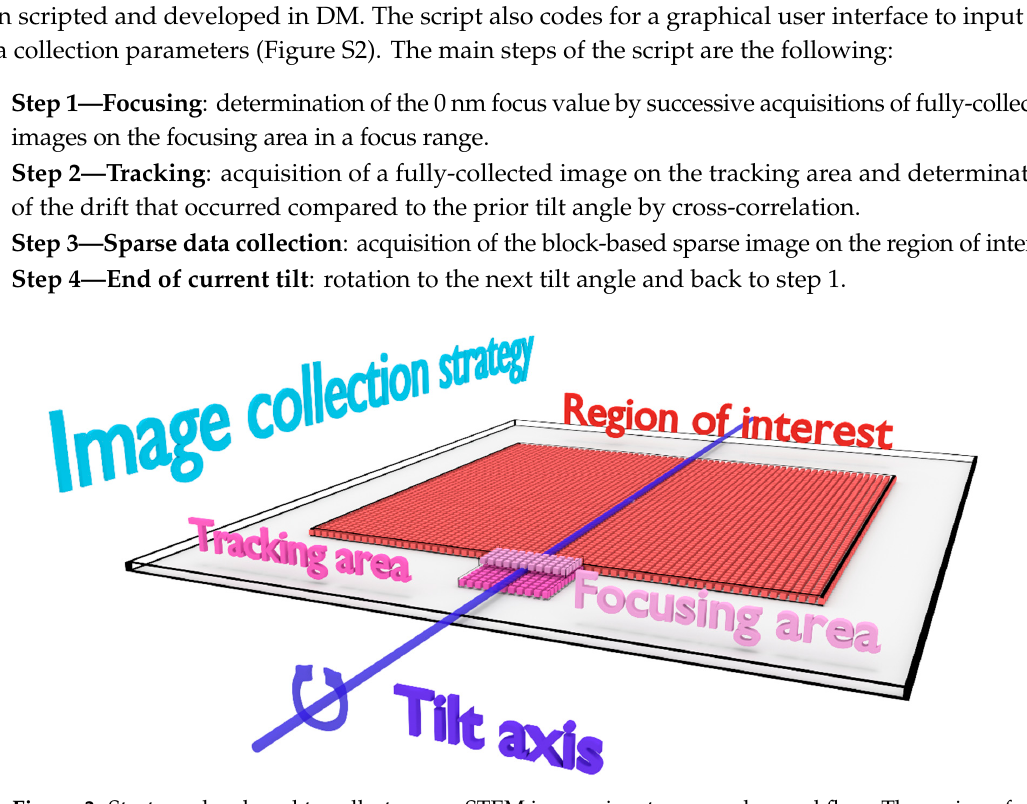
Figure 3. Strategy developed to collect sparse STEM images in a tomography workflow. The region of interest (in red) and the tracking and focusing areas (in dark and light pink respectively) are aligned with the tilt axis (in dark blue). with the tilt axis (in dark